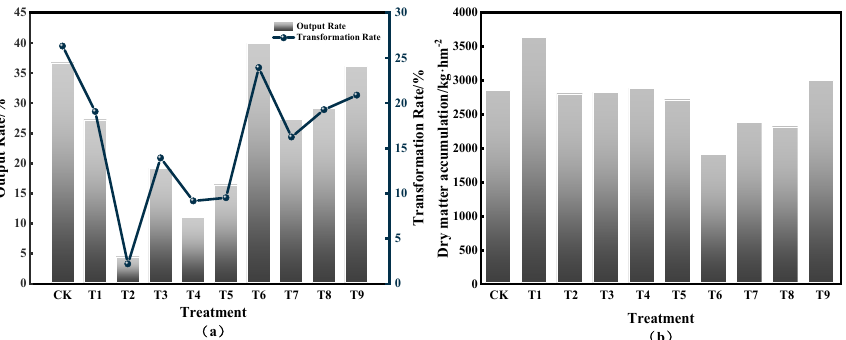
Figure 7. Changes in output, transformation rate, and dry-matter accumulation of mung bean plants by treatment.